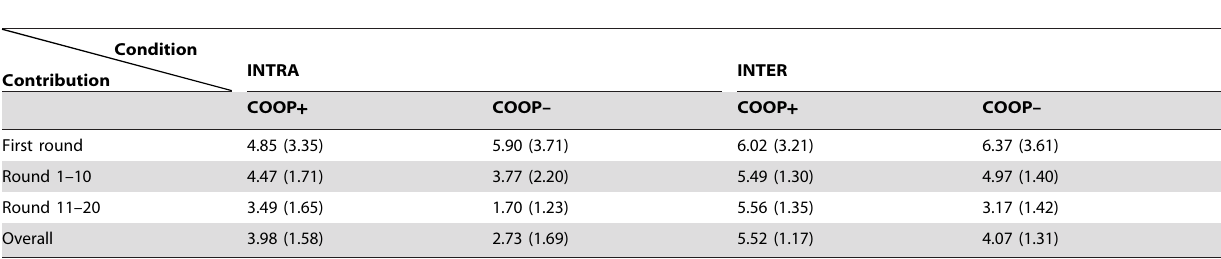
Table 1. Mean values and standard deviations (in brackets) of the first round, the first 10 rounds, the last 10 rounds, and overall contributions by condition.